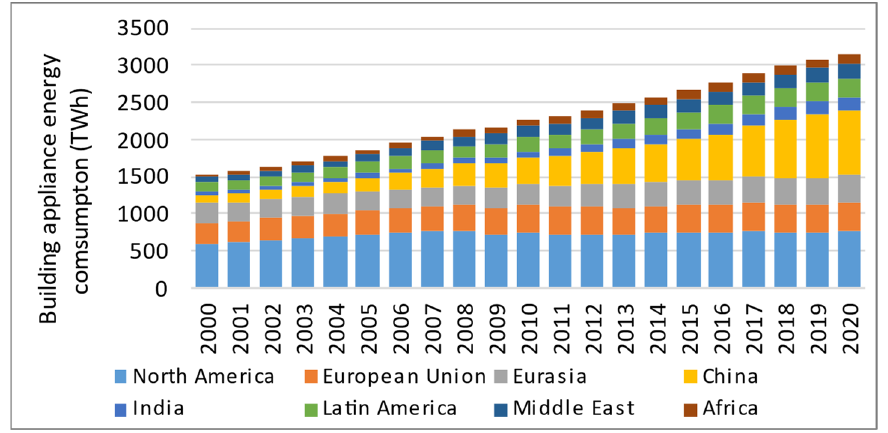
Figure 1. Energy consumption of building appliances by region. Data extracted from IEA [3].